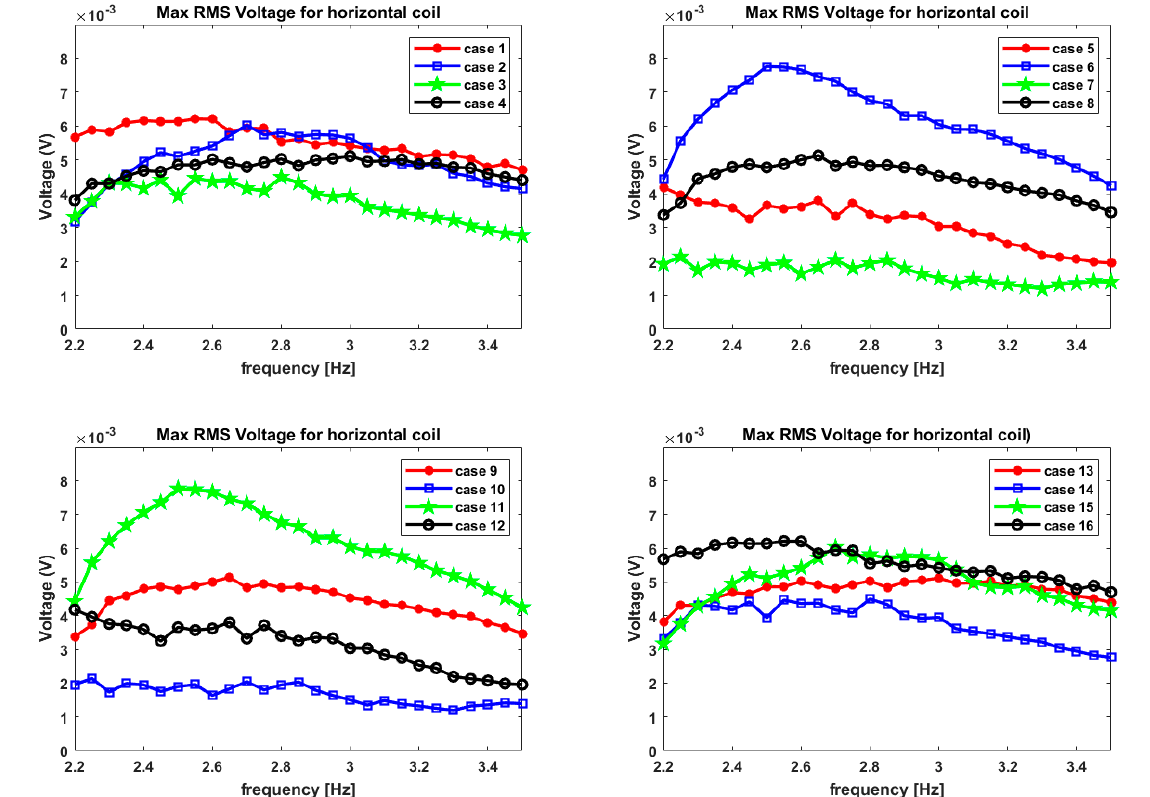
Fluids 2021 , 6 , x FOR PEER REVIEW Figure 16. RMS voltage plots for Cases 1–16 while considering horizontally wound coil for L = 5 cm tank. For, vertical winding the RMS voltages are shown in Figure 17. They are an order of magnitude higher than the max RMS voltage for horizontal coil, as was observed for L = 10 cm tank. Cases 7 and 10 achieved the highest RMS voltage output of around 0.038 V. The symmetric magnet placement in cases 7 and 10 causes the max RMS voltage observed to be identical. As mentioned in the previous sub-section, the symmetric magnet place- ment gives rise to magnetic field profiles inside the tank, which are mirror images of each other, which can be deduced from the direction of the magnetic flux lines for these two cases. Similarly, this applies to the other 14 configurations. It can be observed from the voltages and power plots that eight pairs of cases show identical behavior. This would be true for any such system subjected to oscillatory external excitation.